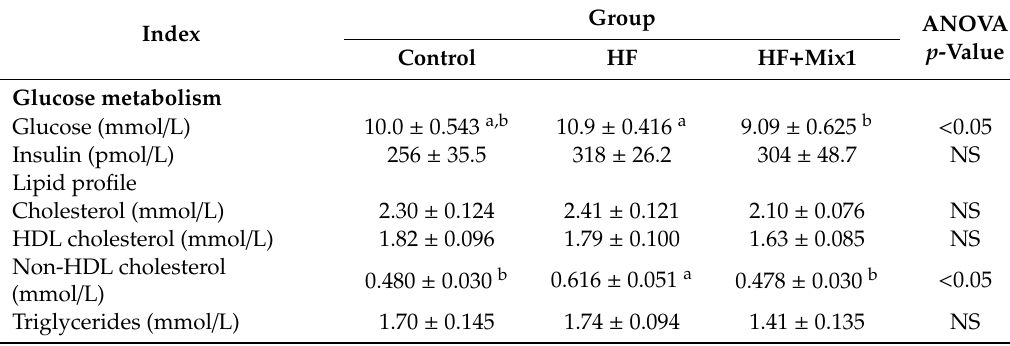
Table 4. E ff ects of mixture 1 on the plasma markers of glucose and lipid metabolism in rats fed a high-fat